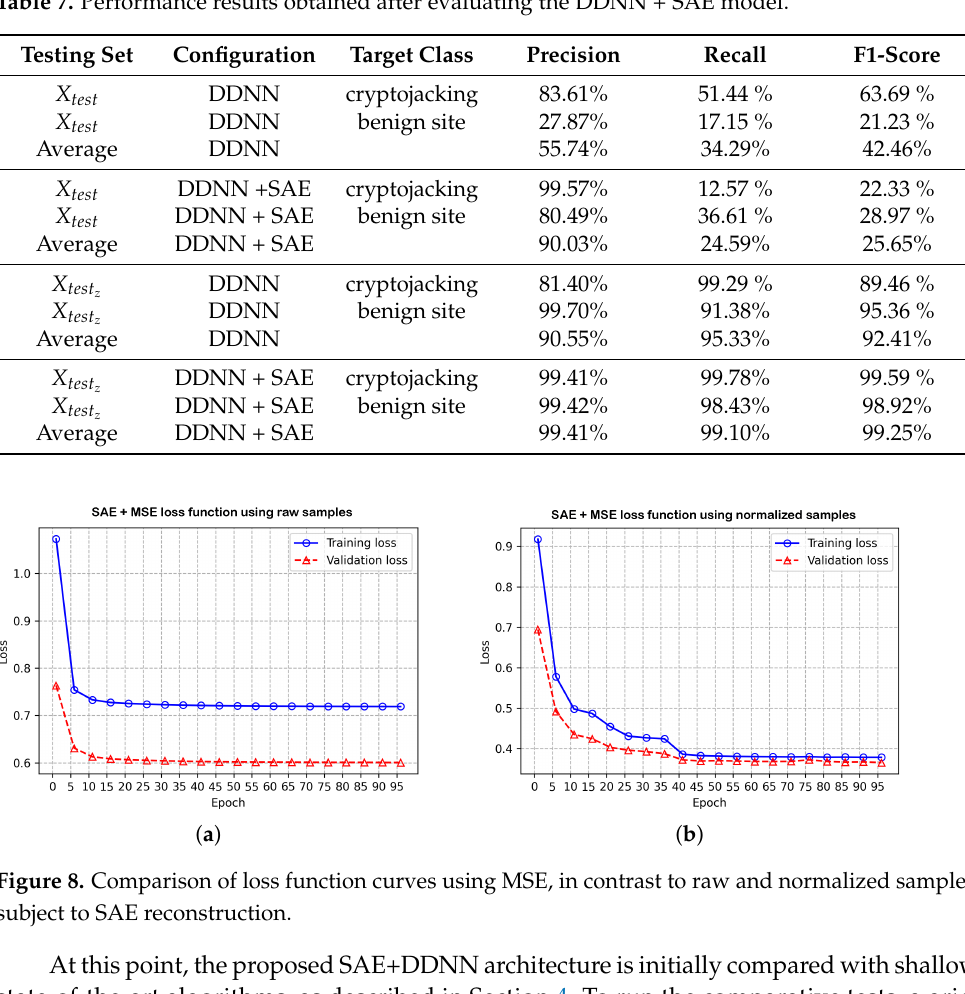
Table 7. Performance results obtained after evaluating the DDNN + SAE model.